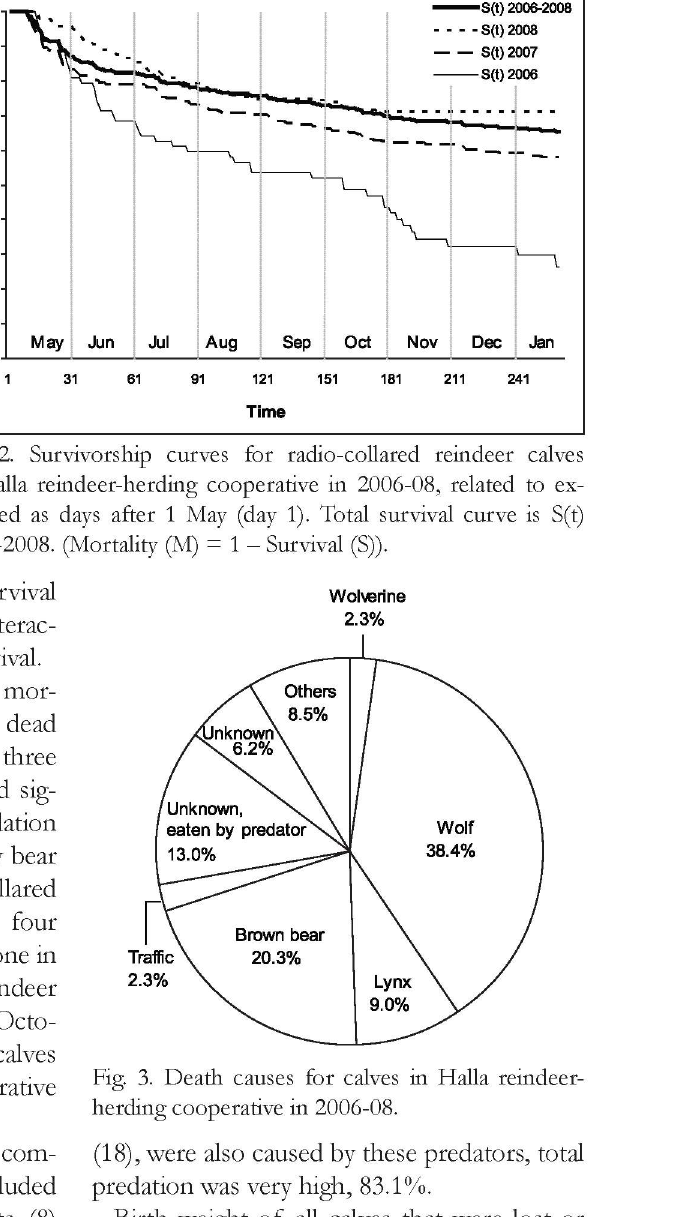
Fig. 3. Death causes for calves in Halla reindeer- herding cooperative in